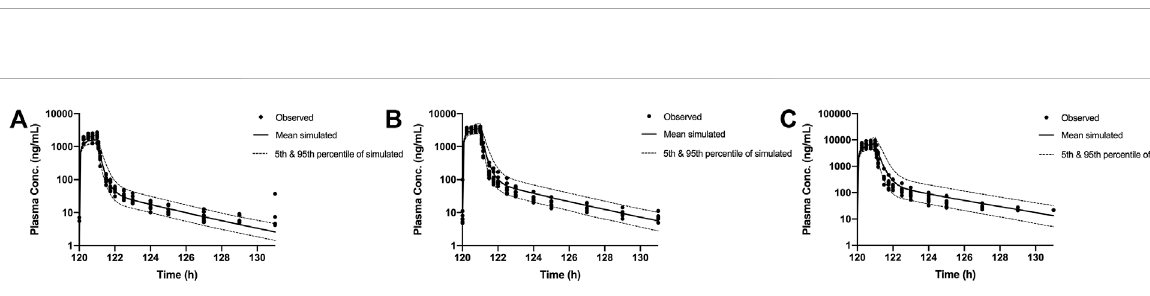
FIGURE 5 Individual observed day 6 plasma concentrations in healthy Chinese subjects after twice-daily doses (60 mg (A) , 120 mg (B) , and 200 mg (C) , symbols). Solid lines show the mean of PBPK concentrations. The dotted lines represent the 5th and 95th percentiles of simulated concentrations. PBPK, physiologically based